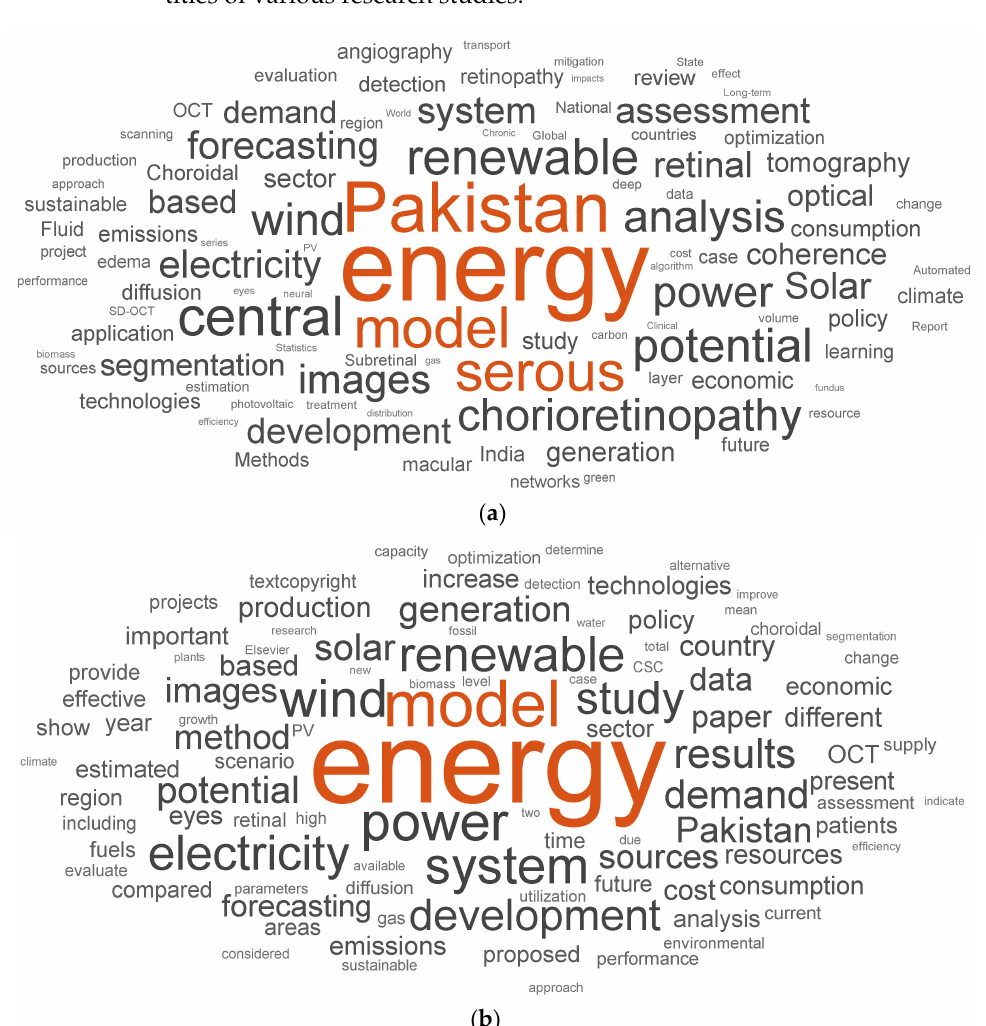
Figure 12. Bibliometric analysis network according to ( a ) title and ( b )